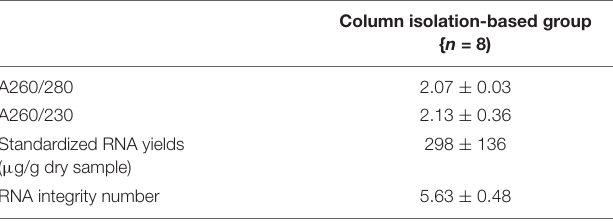
TABLE 1A | RNA characteristics in column isolation-based group and organic isolation-based